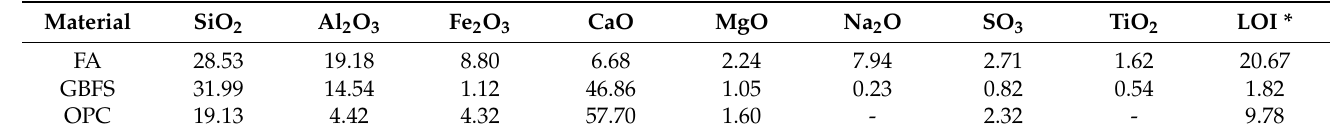
Table 1. Chemical composition of raw materials